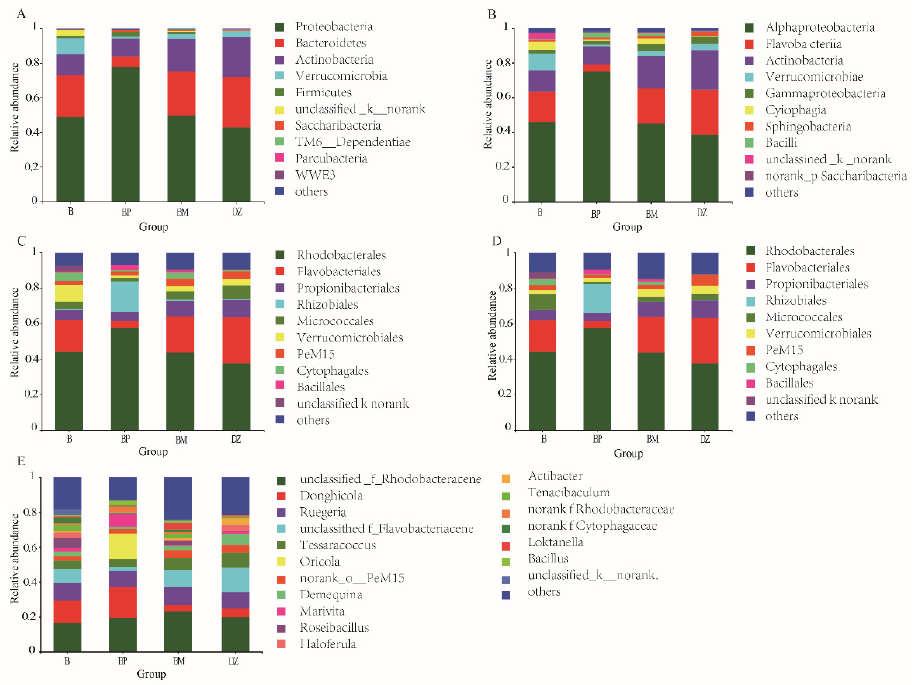
Figure 6. Bacterial composition at different levels of phylum ( A ), class ( B ), order ( C ), family ( D ), and genus level ( E ) in different culture systems. Note: group B, a single B. pumilus BP-171, was added; the group BP, B. pumilus BP-171, and PHBV were added; the group BM, B. pumilus BP-171, and molasses were added; the group DZ, the control without any probiotics and carbon sources addition.